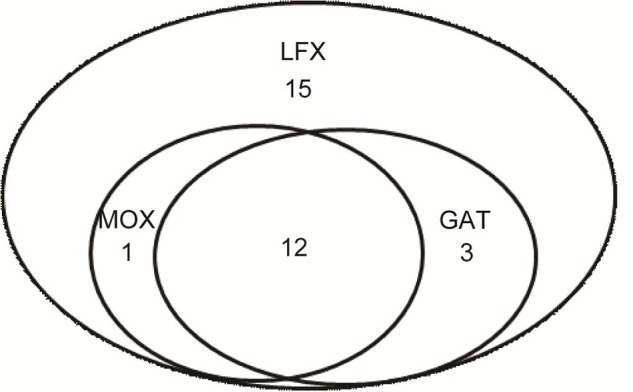
Cross-resistance to fluoroquinolones of Mycobacterium kansasii isolates.